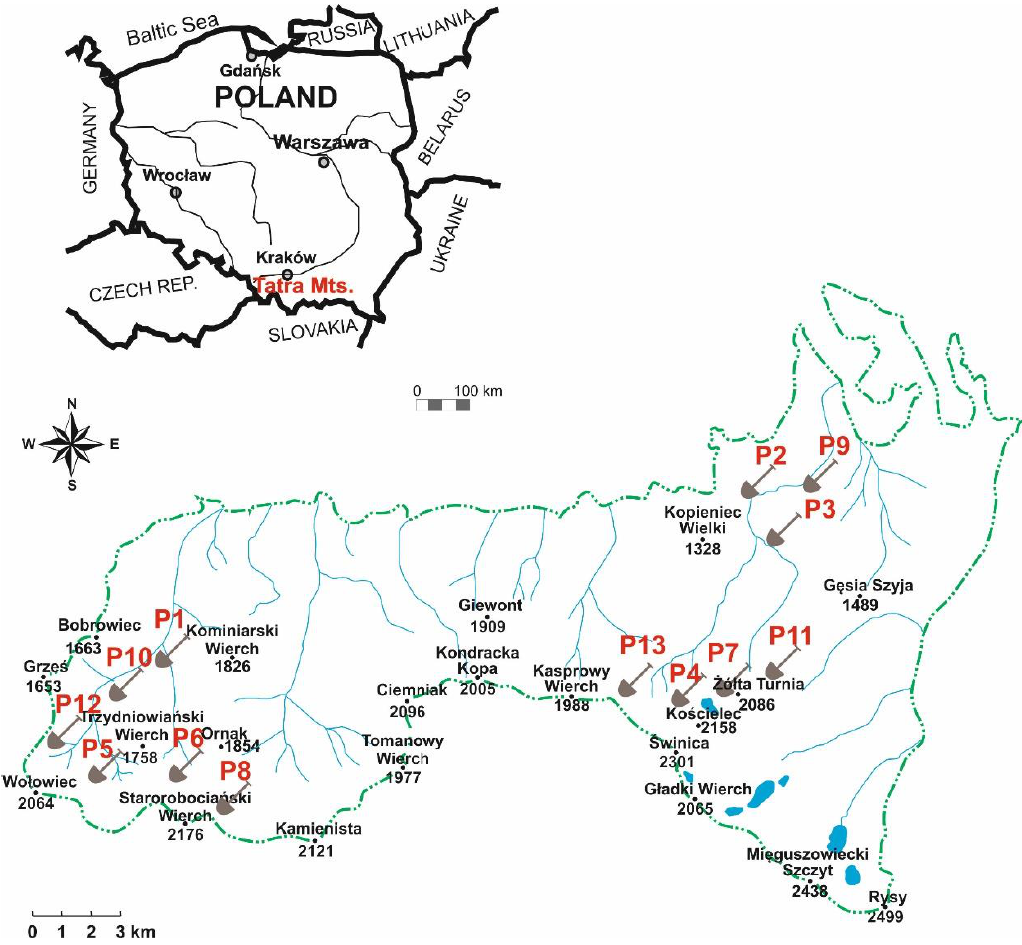
Figure 1. Location of studied soil profiles.